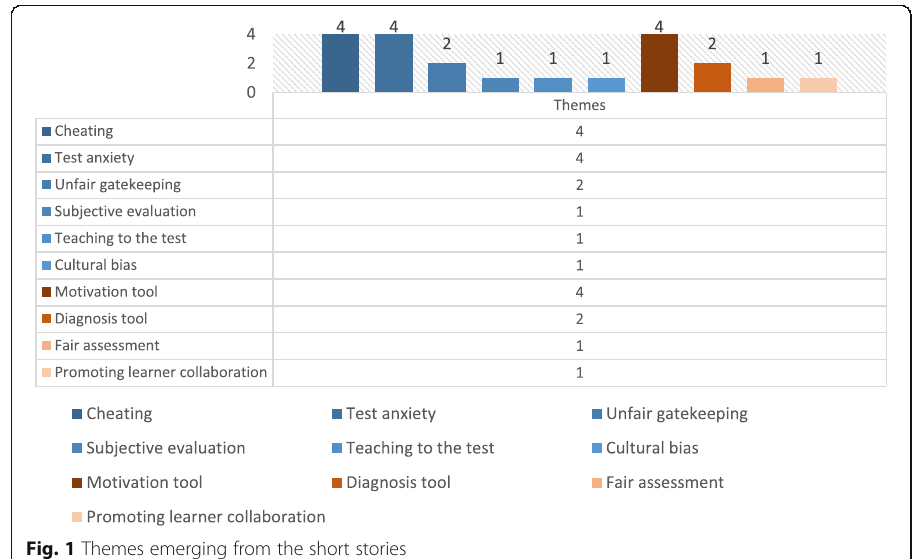
Fig. 1 Themes emerging from the short